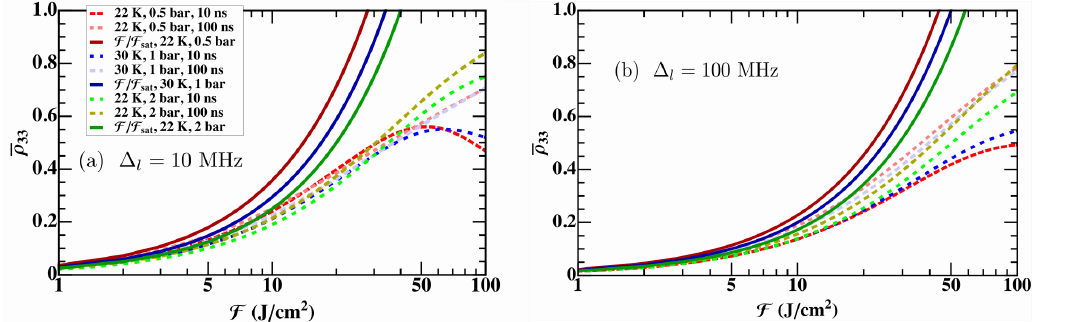
Figure 3: (Color online) ¯ ρ population versus laser fluence for various H target 33 2 F = 10 MHz and ∆ = 100 MHz), and two expo- conditions, two laser bandwidths ( ∆ l l sure times ( τ = 10 ns and τ = 100 ns) in the range of interest for the CREMA HFS experiment. We use the collision rates of Table 1 assuming Boltzmann distribution between ortho- and para-H . The solid lines represent the results from the analyt- 2 ical expression of equation (19) that neglects population dynamics. The saturation fluences are taken from Table F sat